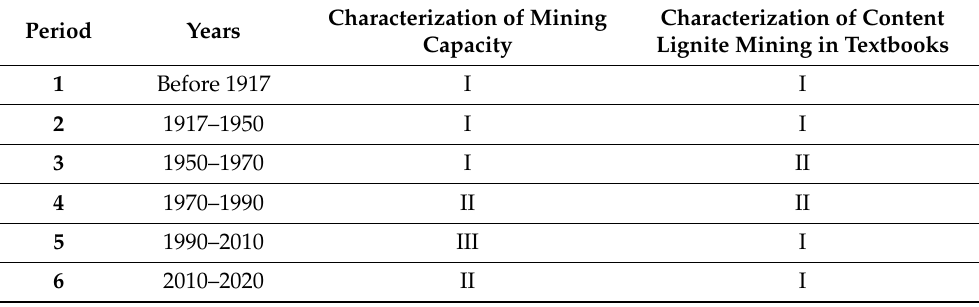
Table 1. Characterization of period